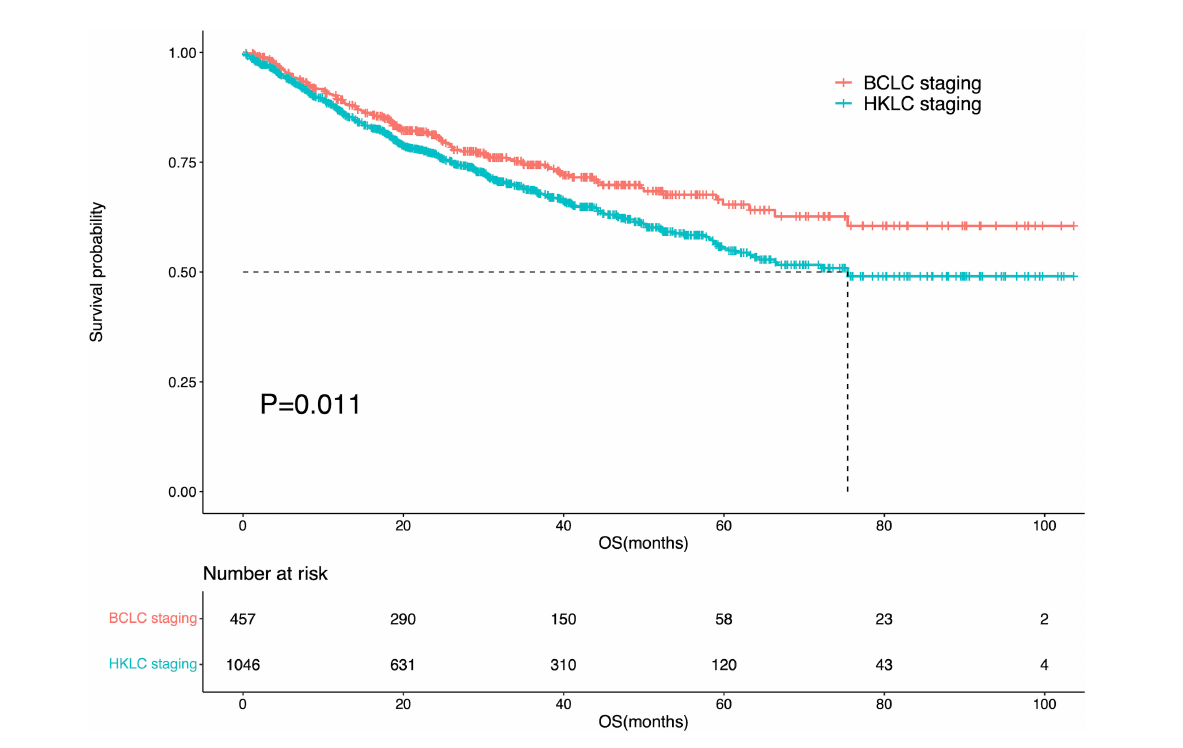
( P < 0.001), and AST ( P < 0.001) levels. The baseline characteristics of the patients in the two groups are compared in Table 3